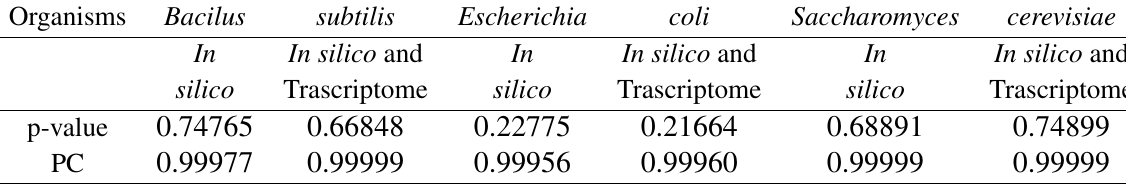
Table 3: Statistical results for the 2-tailed dependent Students t test (p-value) and Pearson Cor- relation (PC) test when comparing flux distributions with altered biomass compositions with the original experimentally determined biomass